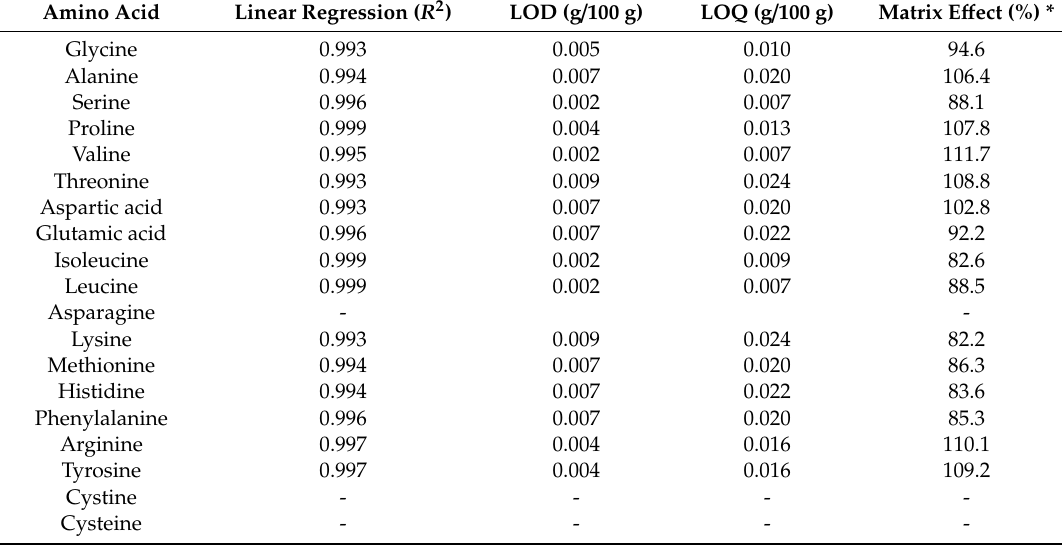
Table 2. Limits of detection (LODs), limits of quantification (LOQs), linear ranges, and linear regression coe ffi cients for the amino acids matrix match calibration in hydrolyzed cereal